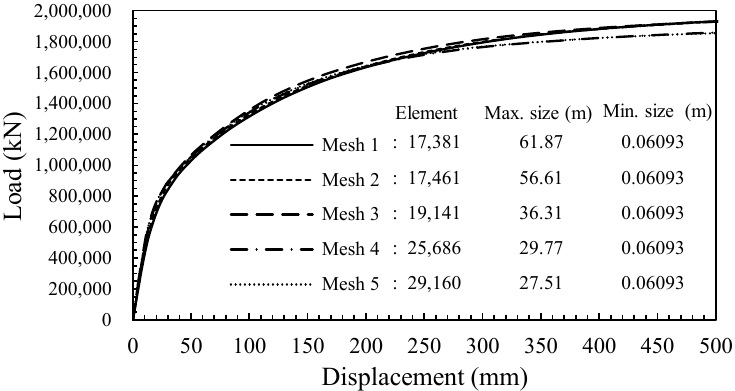
Figure 3. Convergence study for three different mesh densities: load-horizontal displacement curves for tunnel-type anchorages. Table 1. Soil and rock parameters used for this study [26,27].